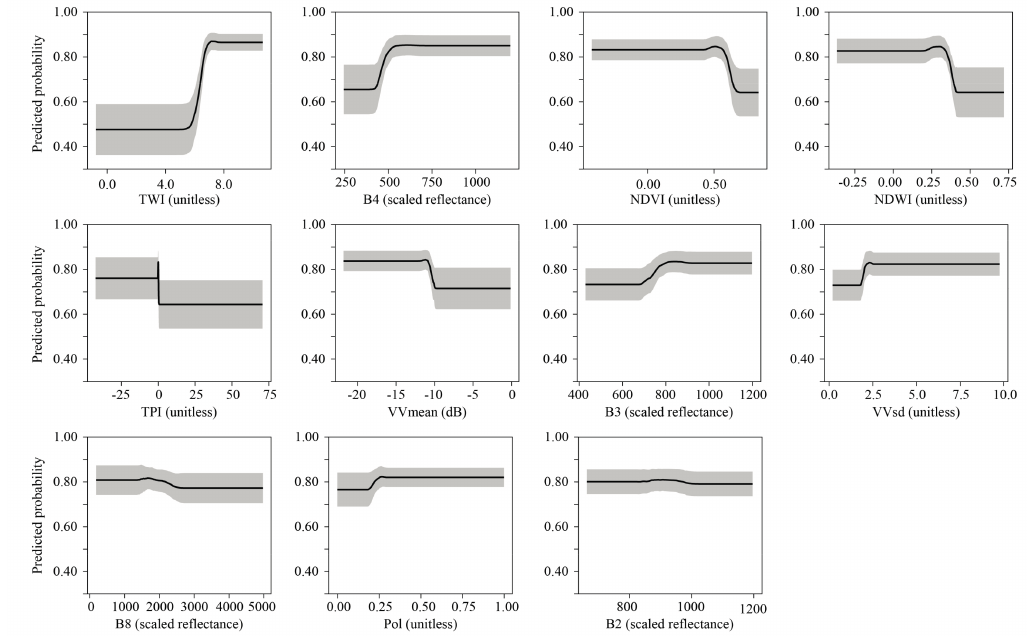
Figure 4. Partial dependence functions, plotted for each input variable in TOS model . Black lines show the 50-iteration function averages for this model, whereas grey lines indicate the function standard deviation across the 50 iteration.